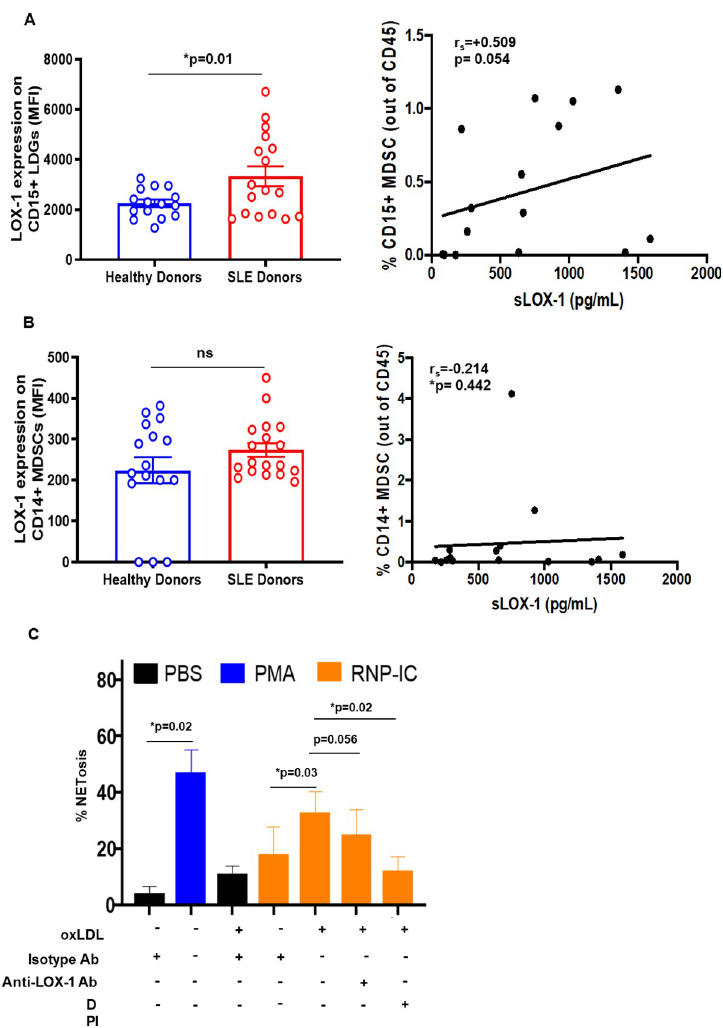
Fig 6. Flow cytometric and functional analysis of low-density granulocytes (LDGs) from SLE patients. Flow cytometric analysis was performed on PBMCs from SLE patients (n = 17) and healthy individuals (n = 15) for LOX-1 expression. After gating out CD3 + /CD19 + /CD20 + /CD56 + /HLADR + cells, CD33 + and CD11b + cells were separated based on CD14 and CD15 expression. Membrane LOX-1 (MFI) levels were determined in (A) CD14 + monocytic myeloid derived suppressor cells (MDSCs) and (B) CD15+ LDGs. (C) NET generation (MPO-red dye) from CD15 + LDGs following 3h oxLDL pre-treatment and stimulation with patient-derived RNP-immune complexes for 4h was observed. n = 4. Data represented as mean ± SEM. � p < 0.05.